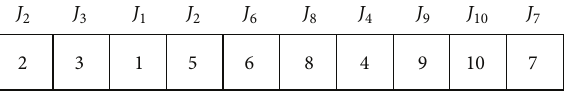
Figure 1: Solution representation.